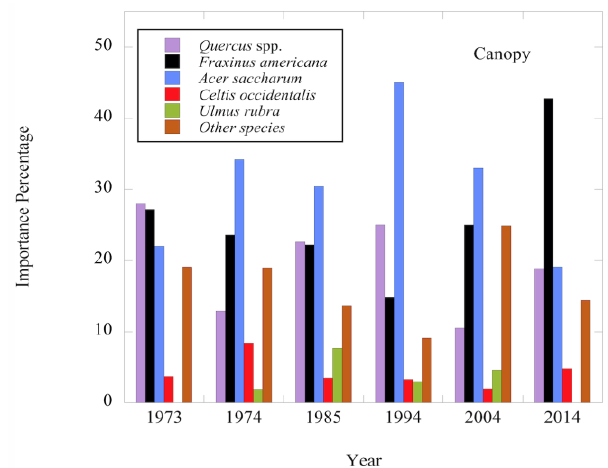
Figure 6. Importance percentage (IP = (Relative Density + Relative Basal Area)/2) for tree species